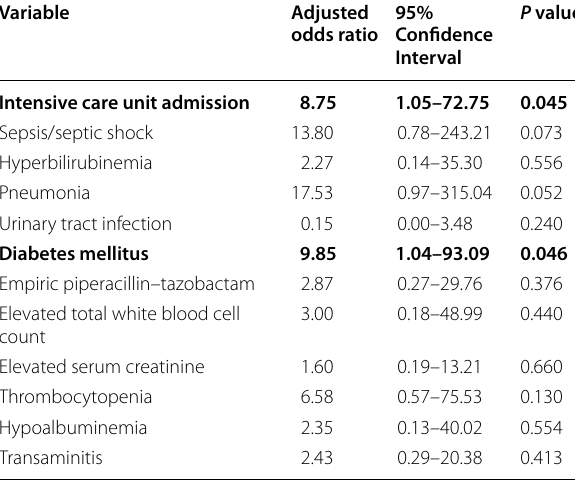
Table 6 Multivariate logistic regression analysis for factors associated with in-hospital